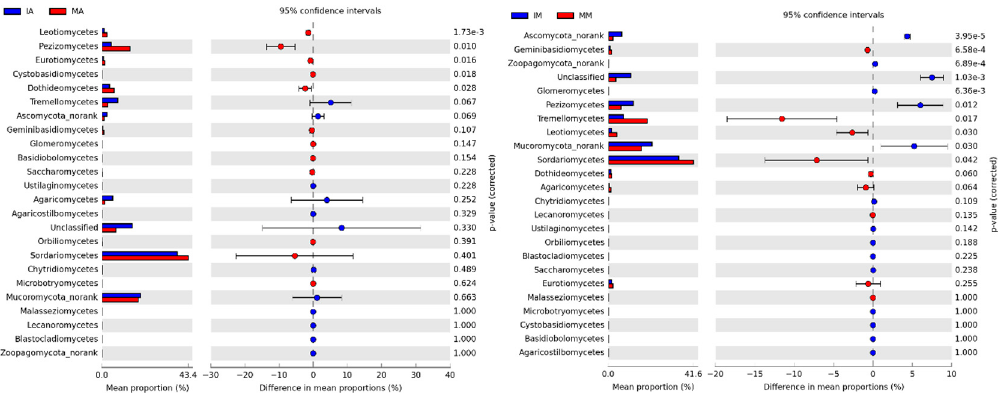
Figure 3. Statistical Analysis of Metagenomic Profiles (STAMP) analysis plots showing the differences in fungal classes in monoculture and intercropping mulberry soil (left) to those in monoculture and intercropping alfalfa soil (right). Welch’s t -test was applied to test for differences in fungal classes due to planting pattern. The p -values are also shown. Glomeromycetes , Pezizomycetes , and Mucoromycota showed higher relative abundances in intercropped mulberry ( p < 0.05). Leotiomycetes , Pezizomycetes , Eurotiomycetes , Cystobasidiomycetes , and Dothideomycetes presented higher relative abundances in the monoculture alfalfa ( p < 0.05).